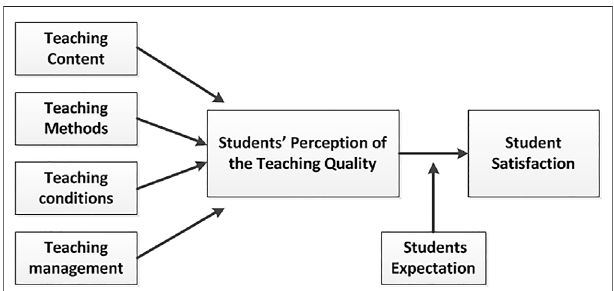
FIGURE 1 | Students ’ perception of the teaching quality of Fundamentals of Entrepreneurship — conceptual model of student